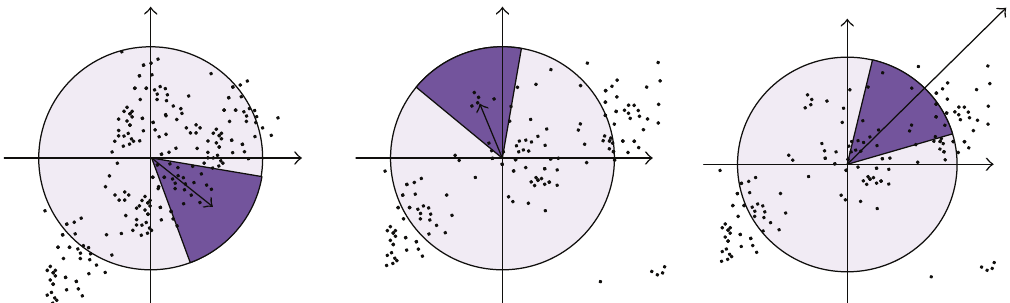
Figure 4: Determine the main direction of the feature point.